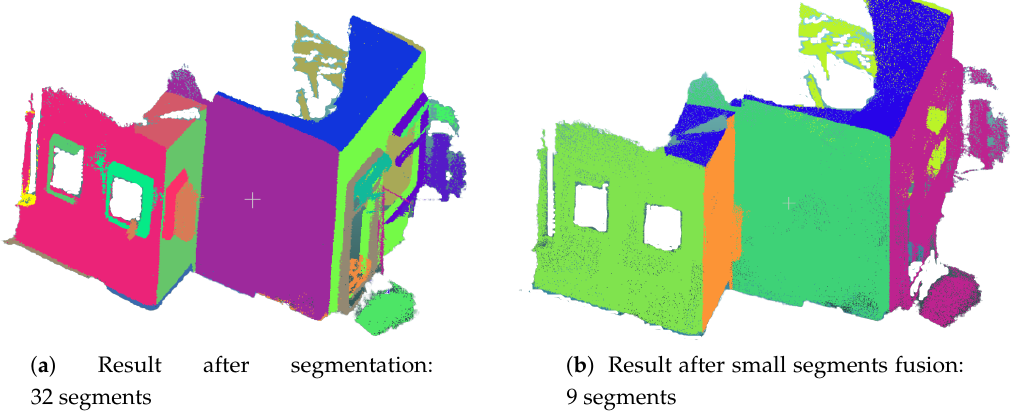
Figure 6. Example of small planes fusion after segmentation. Table 1. LCP-4PCS execution time before and after merging small